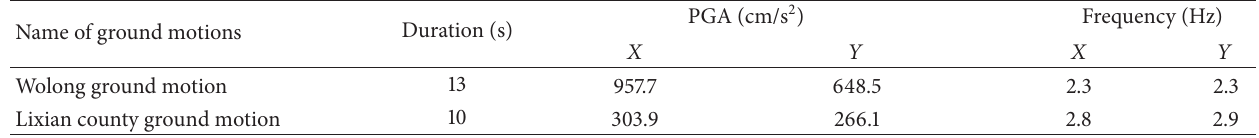
Table 2: Ground motion parameters.